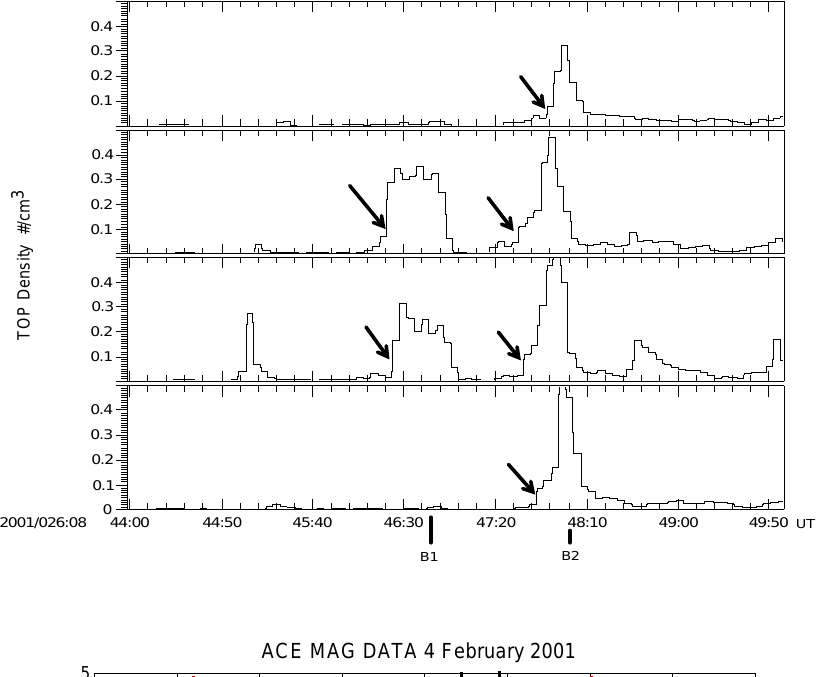
Fig. 8. IMF conditions from the ACE spacecraft for 4 February 2001, in GSE coordinates. The solar wind speed at this time was ∼ 310km/s, giving a lag time to Cluster of ∼ 84 min. Using this time, we have indicated the extent of the Cluster observations in Fig. 9 by the red vertical lines. From this region we can see that during the Cluster pas- sage, the IMF is northward with sev- eral changes in the direction of B Y . The region bounded by the solid black ver- tical lines corresponds to a ∼ 15 min period around B in Fig. 9, highlighting two ∼ 2min variations in the IMF B X and B Y